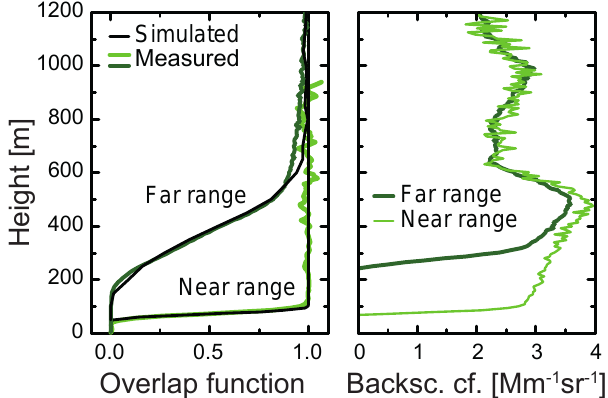
Figure 11. Left: simulated (thin, black) and experimentally deter- mined (thick, green) overlap functions of far-range and near-range telescopes of Polly XT _OCEANET. Right: Backscatter coefficient at 532nm derived with the Klett method (lidar ratio: 30sr, no overlap correction performed) from far-range (thick, dark green) and near- range (thin, light green) signal from a measurement aboard RV Me- teor on 5 May 2013 form